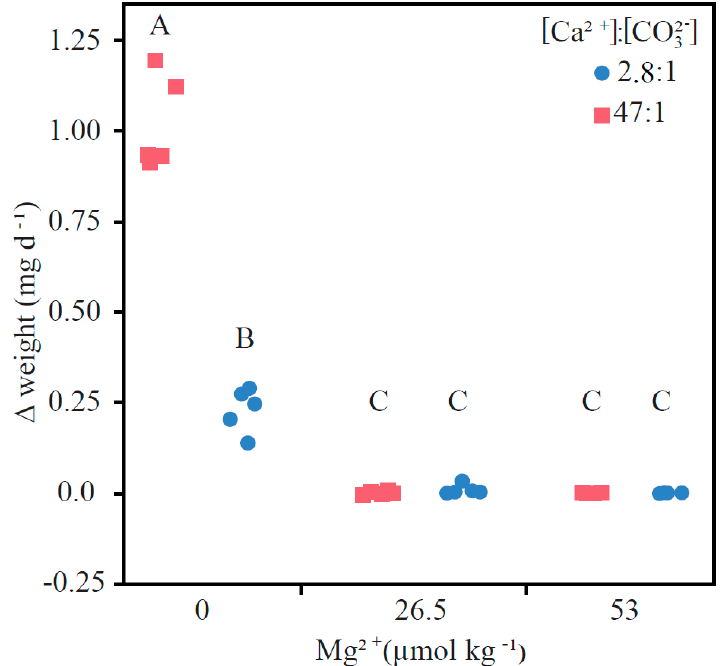
Figure 3. Scatter plot showing the standardized total weight change per day [mg d − 1 ] of each experimental scenario. The data shows a clear inhibiting effect of Mg and 2.8:1 Ca:CO 3 stoichiometry towards inorganic mineralization. Treatments not connected by the same alphabetical symbol (A, B, or C) are significantly different as shown in Table 2; F [2,24] = 150.924, p < 0.001. Table 2. Two-way factorial ANOVA and least square (LS) means difference. The effect test showed significant interaction between Ca:CO 3 and Mg concentration. Tukey–Kramer HSD com- parisons indicates a significant difference between Mg-free and high Ca:CO 3 , and all other treat- ments, as well as Mg-free and low Ca:CO 3 and all other treatments.